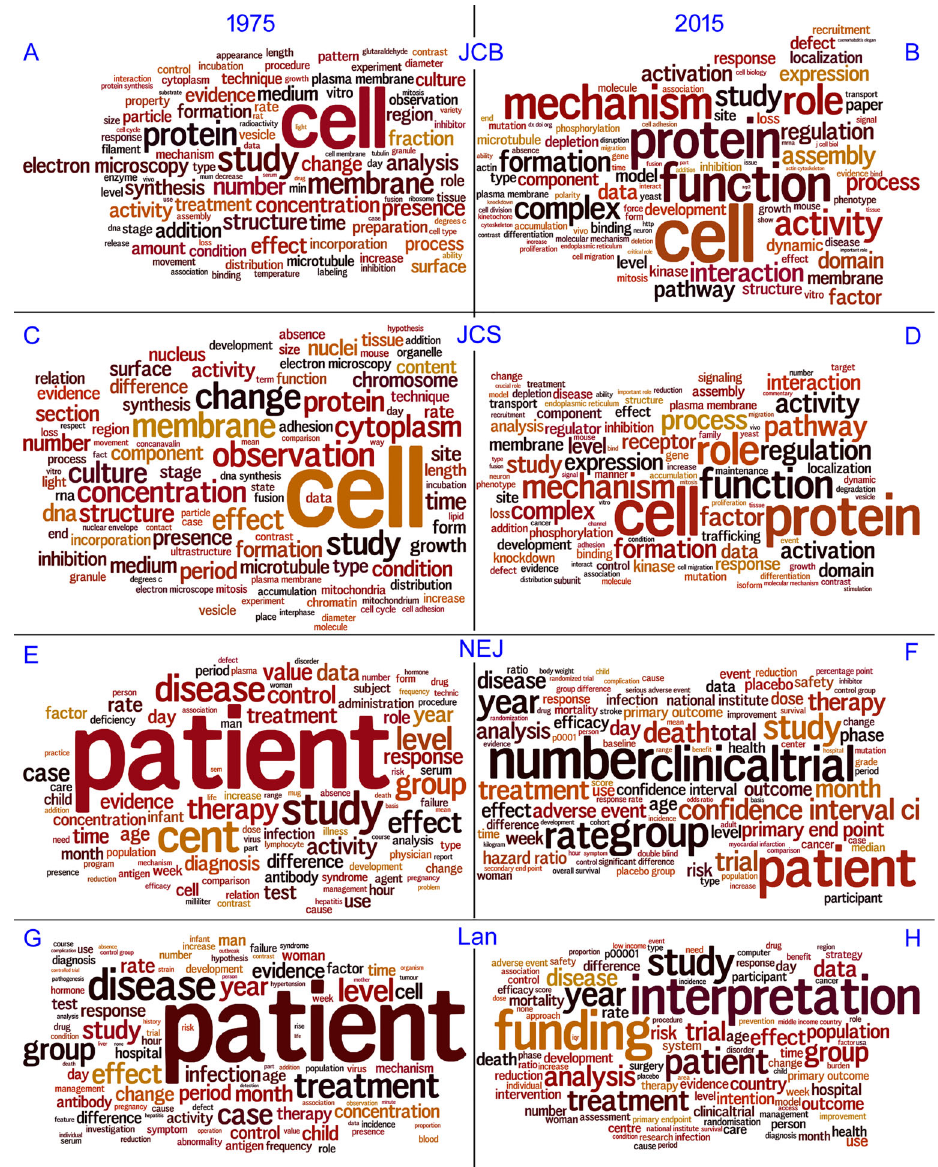
Figure 3. Vocabulary comparison over time in cell biology and medical journals using word clouds. The vocabulary of cell biology journals changed more over time than of the medical journals. JCB: Journal of Cell Biology; JCS: Journal of Cell Science; Lan: Lancet; NEJ: New England Journal of